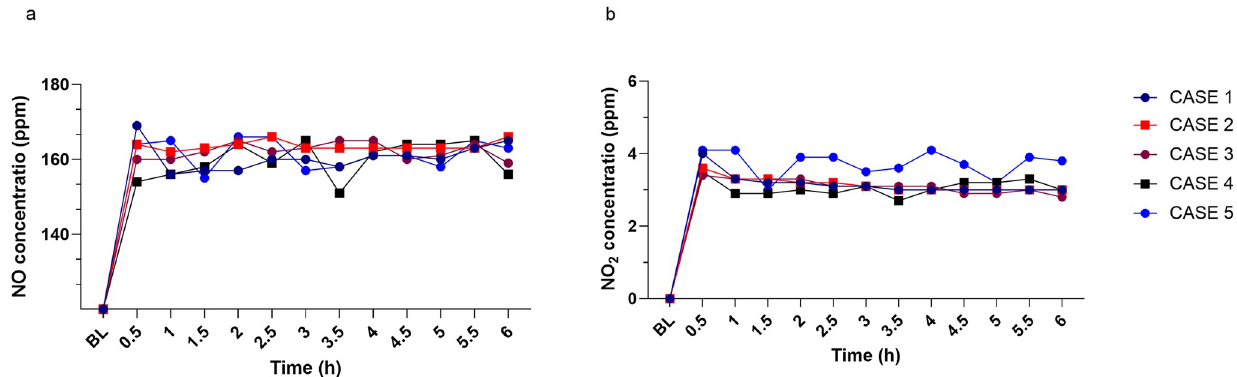
Fig 3. High-dose nitric oxide (NO) delivery and nitrogen dioxide (NO 2 ) formation. Various parameters of the delivery system were monitored during 6 h of continuous exposure to a pre-set concentration of NO (160 ppm). (a) The NO concentration in the inspiratory line monitored with an electrochemical analyzer (AeroNOx, International Biomedical, TX, United States). The maximum variation observed was 161.6 ± 3.53 ppm, with the highest dose reaching 169 ppm of the pre-set concentration. (b) The buildup of nitrogen dioxide was monitored during the same period of exposure. The NO2 level remained below the safety threshold (5.0 ppm), during the entire experiment, with an average level of 3.24 ± 0.35 ppm. Data are presented as single data points from each individual case: CASE 1 ( ), CASE 2 ( ), CASE 3 ( ), CASE 4 ( ), and CASE 5 ( ). Definition of abbreviations: BL = baseline, ppm = parts per million, NO = nitric oxide, and NO 2 = nitrogen